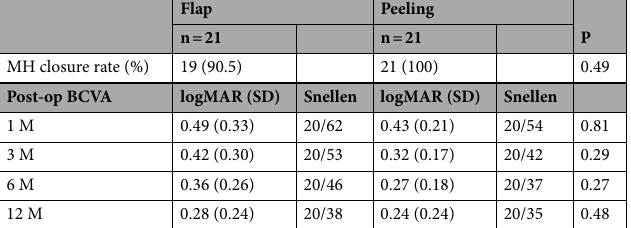
Table 2. Postoperative changes in BCVA and the MH closure rate of the flap group and the peeling group. Wilcoxon’s rank-sum test, Fisher’s exact test. BCVA best-corrected visual acuity, MH macular hole, logMAR logarithm of minimum angle of resolution, SD standard deviation, post-op